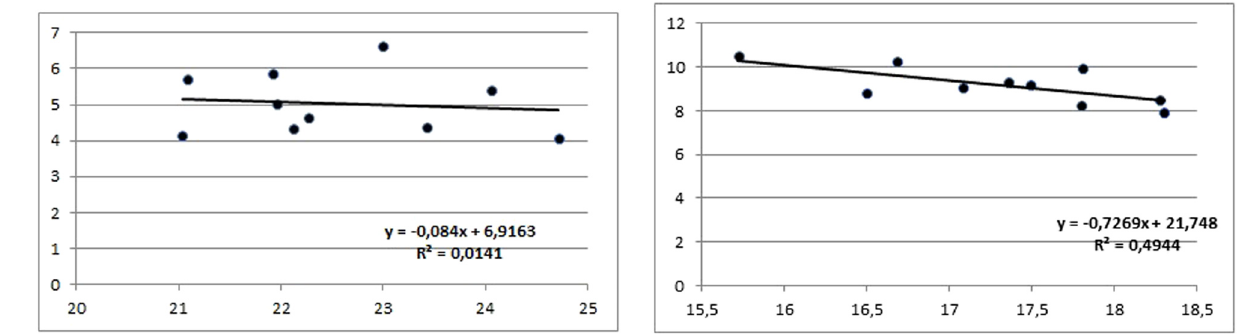
Figure 5: Linear approximation of the dependence of meat content on fat content in the cervical - scapular third of the carcass at a slaughter weight of 110